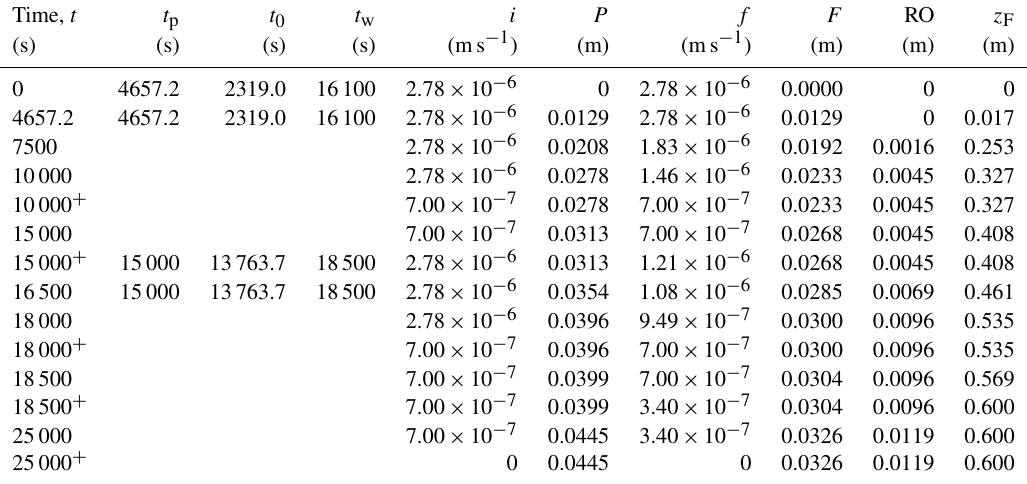
Table 2. Infiltration and excess runoff calculations for an illustrative unsteady rainfall event on a clay soil with no initial ponding at equilib- rium with a shallow water table at 150cm depth, s max = 0, and end vertical boundary conditions. The “ + ” sign in the first column represents any time right after the beginning of that time